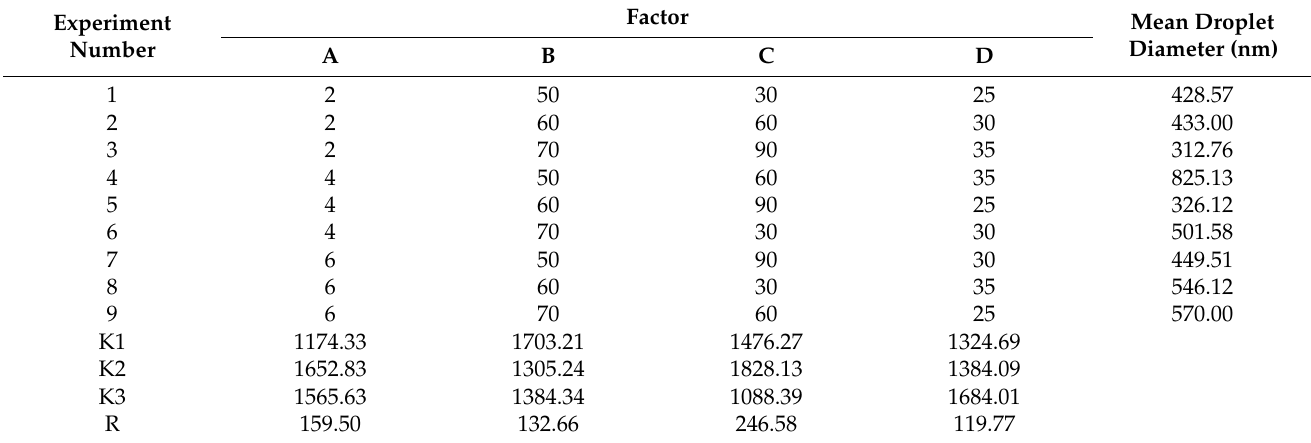
Table 2. Orthogonal experiment design and results concerning mean droplet